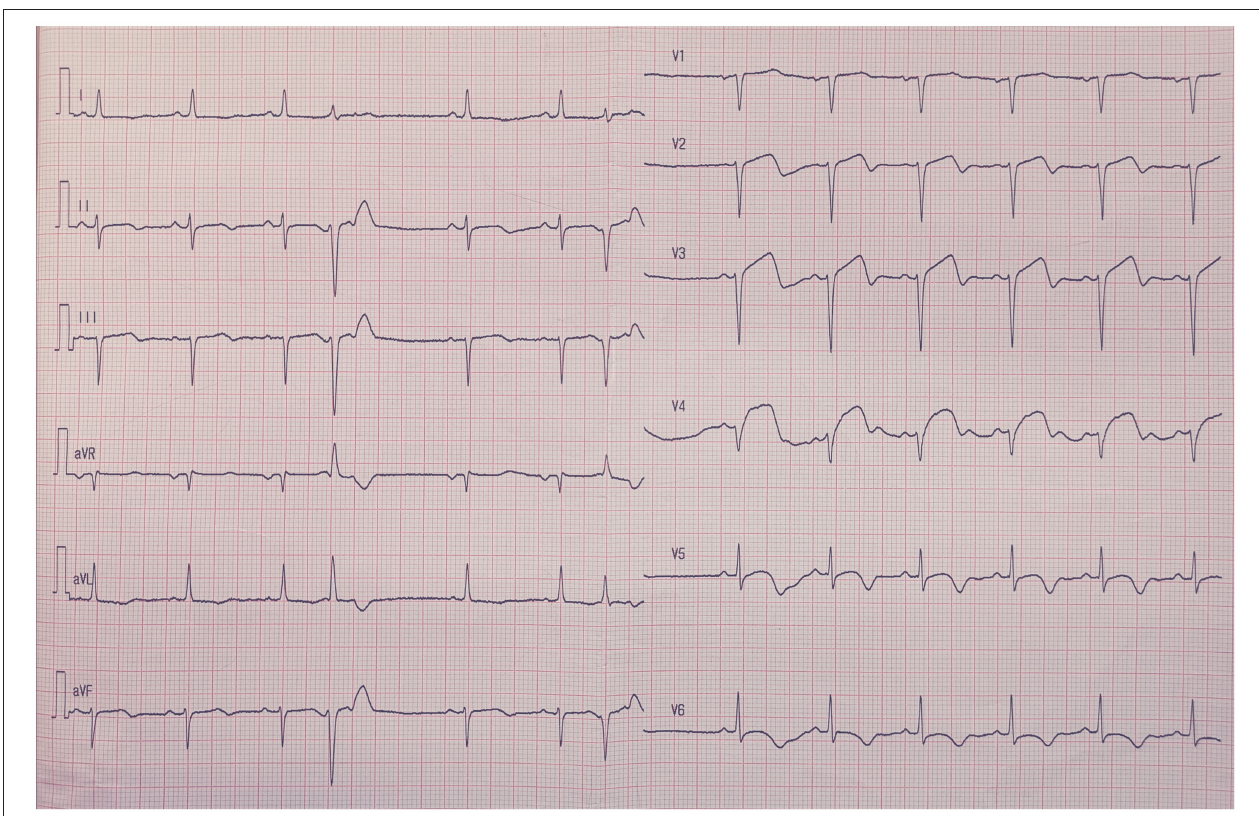
FIGURE 2 | The electrocardiography feature of acute myocardial infarction. ST-segment elevation in two adjacent leads (V3–V4), with r-wave/Q-wave formation, and inverted or bidirectional T waves.